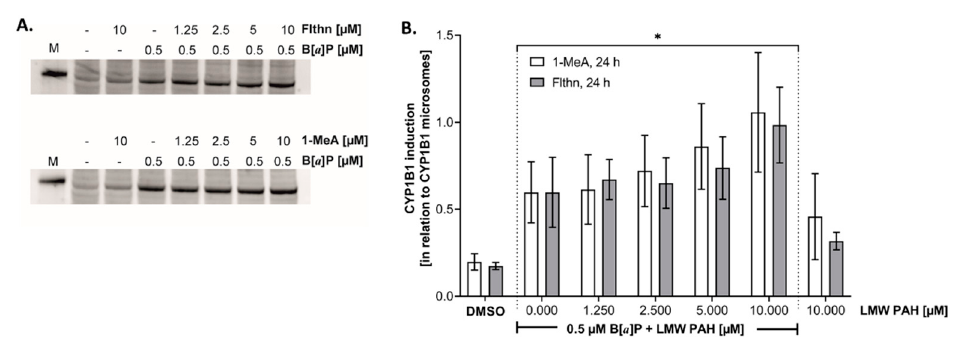
Figure 5. Cytochrome p450 1B1 immunoblots in A549 cells following PAH exposure. ( A ) Im- munoblot of A549 cells treated with B[ a ]P, 1-MeA, Flthn, or B[ a ]P combined with 1-MeA or Flthn for several concentrations. M = CYP1B1 microsomes (62.5 nL). ( B ) Graphic representation of the A549 immunoblots (n = 3 per samples repeated 3 times). * p < 0.05 compared to DMSO control.